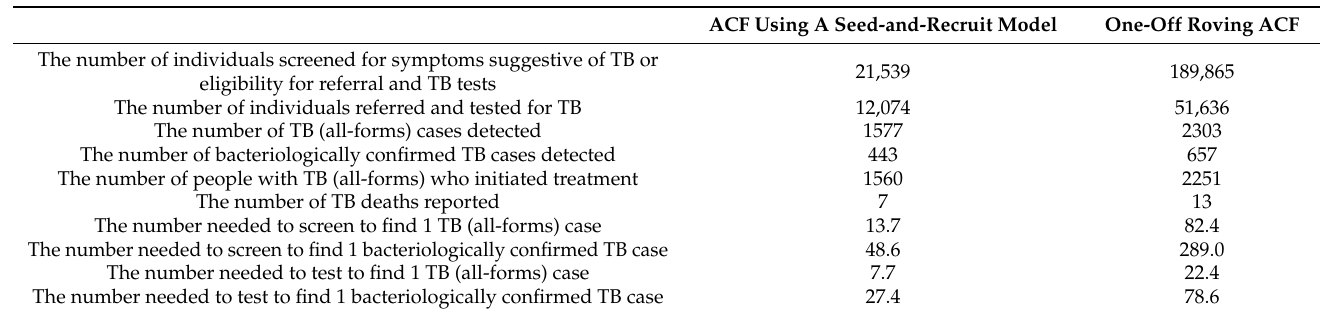
Table 2. TB active case-finding program outputs.